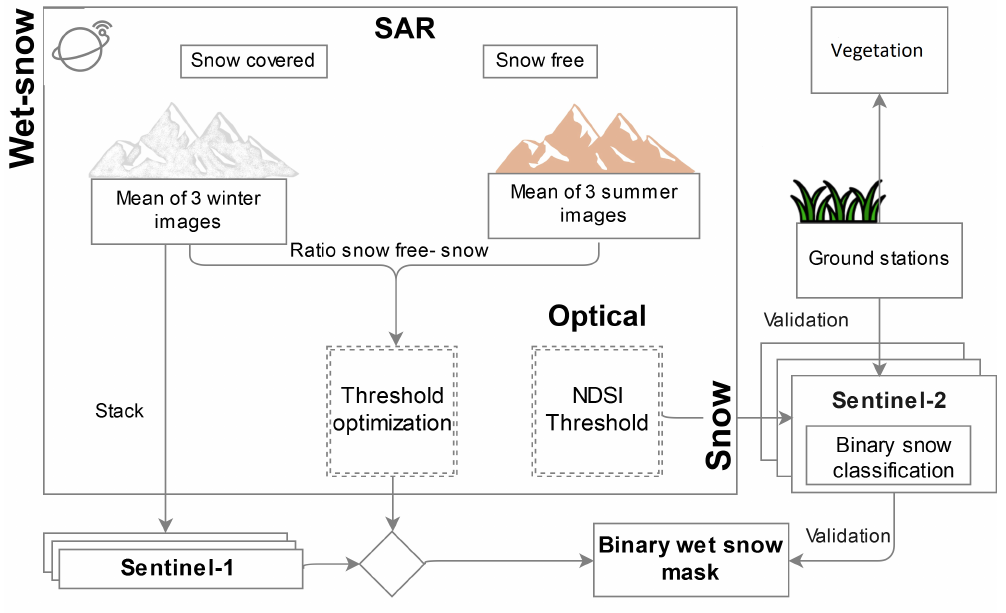
Figure 3. Flow chart of the proposed approach to detect the main features of snow season and